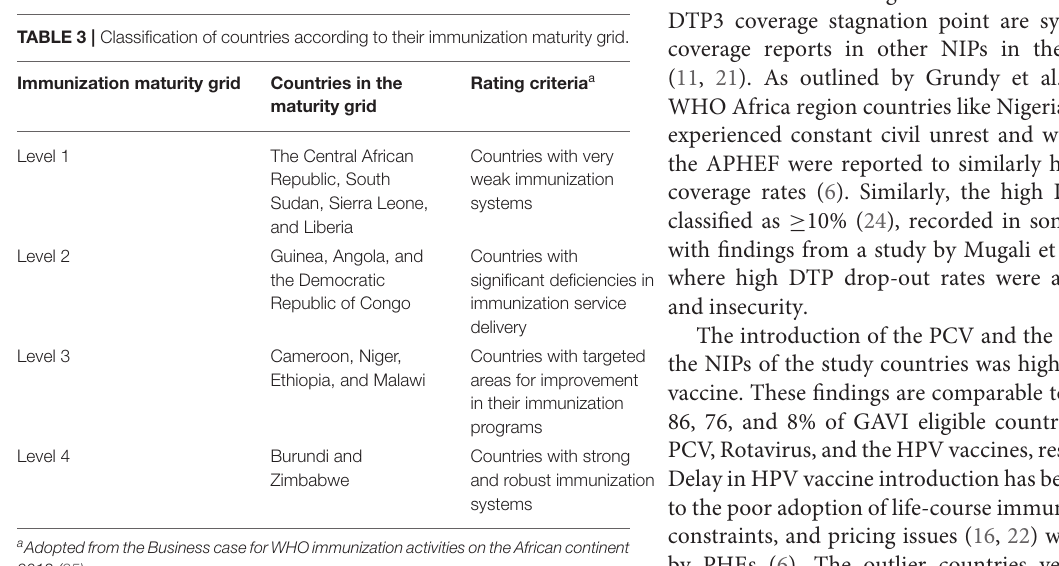
TABLE 4 | A Comparison of PHE count across two target groups of immunization indicators outlined in the DoV.